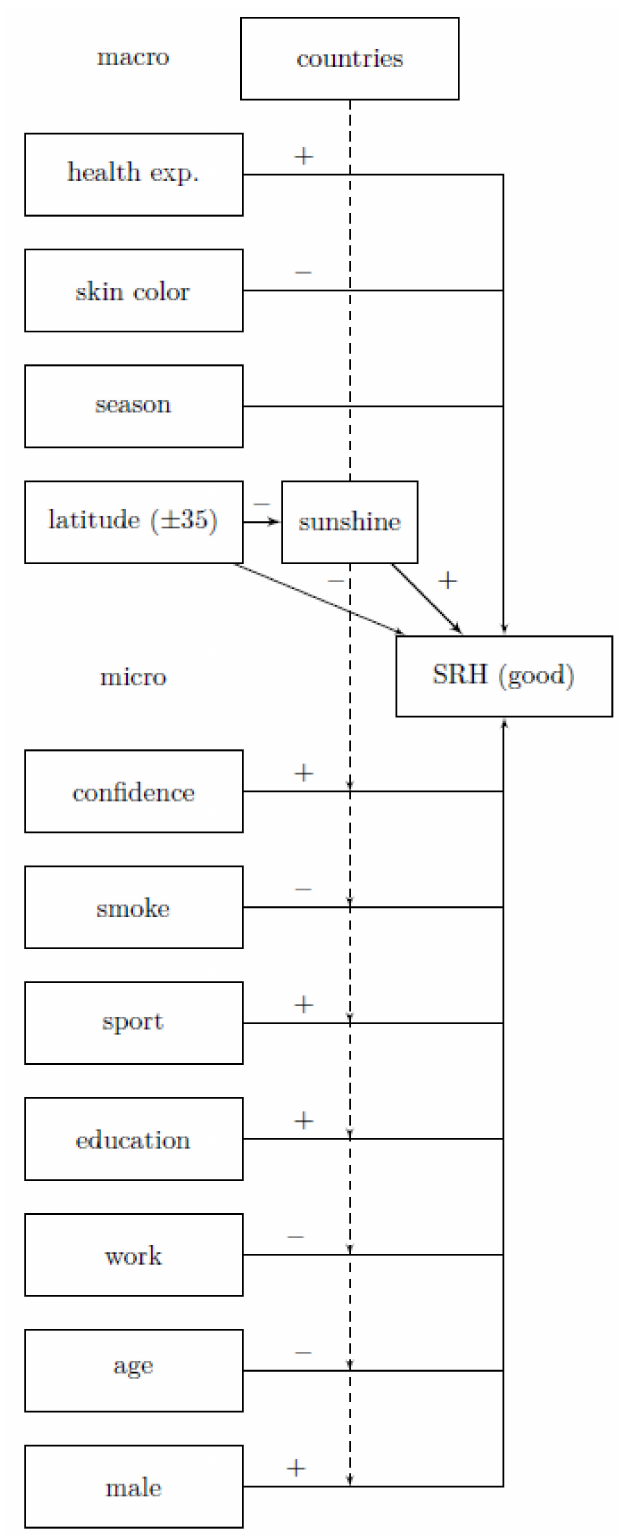
Figure 1. Description of relevant mechanisms related to sun exposure and self-rated health, health exp. = domestic general government health care expenditures (as a % of gross domestic product), interaction from age and sunshine hours not shown, own representation, [ ± 35] means all values above 35 ◦ N and below 35 ◦ S